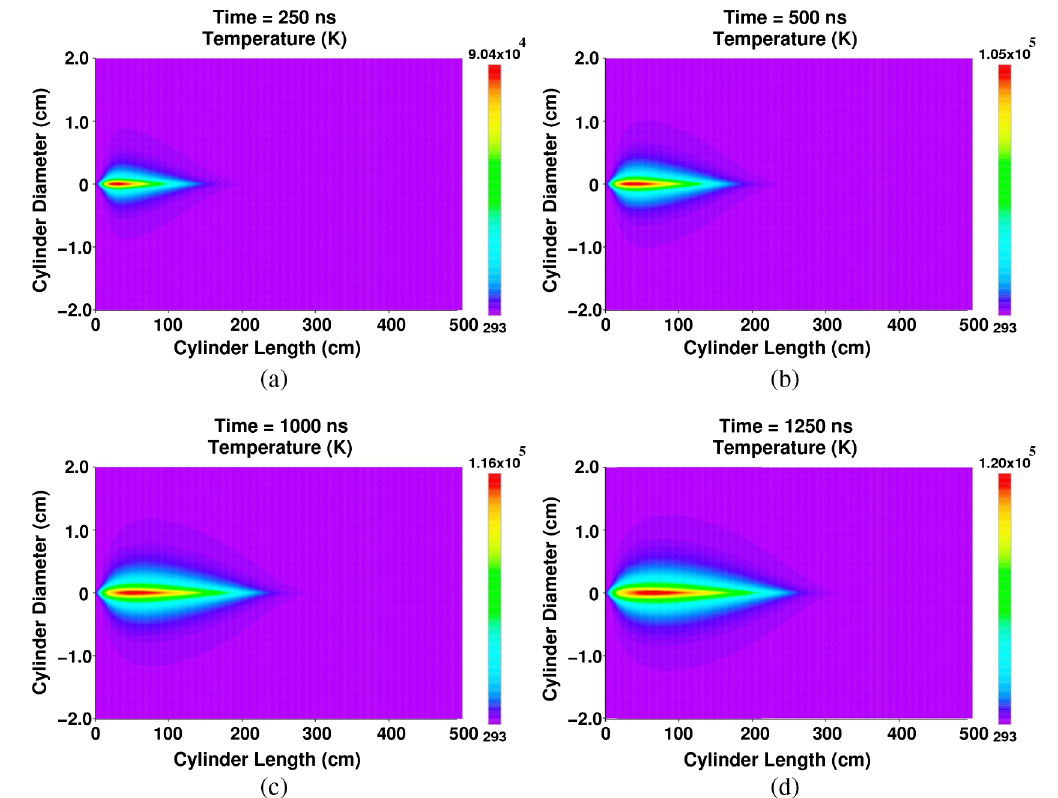
FIG. 4. Temperature distribution in the target calculated by BIG 2 (a) at t ¼ 250 ns (10 bunches delivered), (b) at t ¼ 500 ns (20 bunches delivered), (c) at t ¼ 1000 ns (40 bunches delivered), and (d) at t ¼ 1250 ns (50 bunches